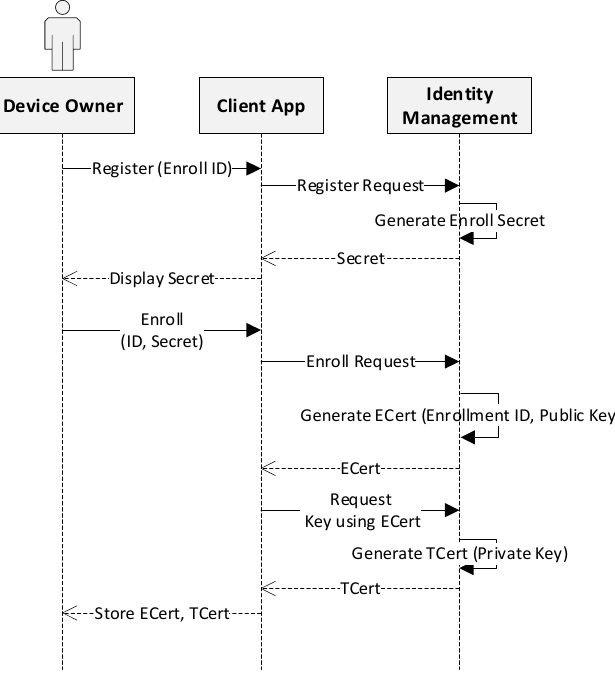
Figure 6. Identity issue for network user.